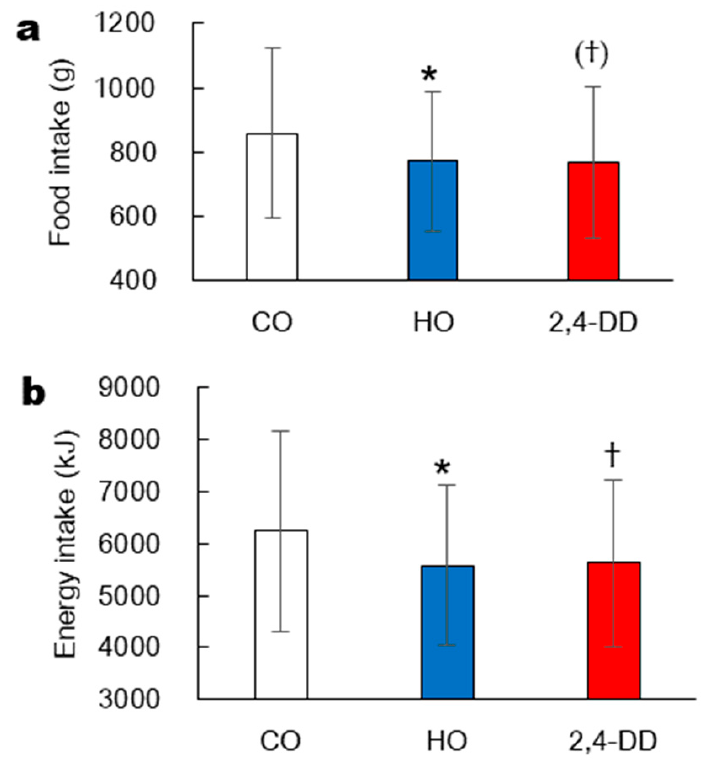
Figure 5. Food intake ( a ) and energy intake ( b ) at ad libitum test meal: 60 min after consuming pumpkin soup (240 g) containing 3.1 g of either intact corn oil (CO), heated corn oil (HO), or CO plus 1 mg of 2,4-decadienal (2,4-DD) in Experiment 2. Data are shown as mean ± SD. * p < 0.05 (CO vs. HO), † and (†) p < 0.05 and p = 0.06, respectively (CO vs. 2,4 ‐ DD).